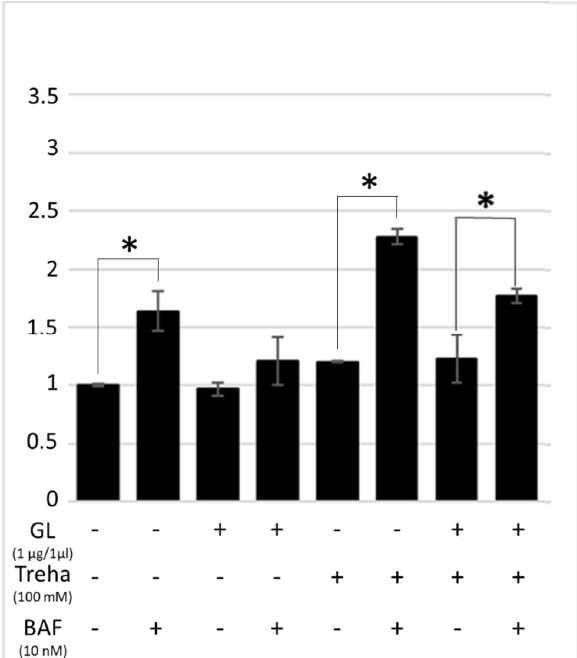
Figure 9. Cytofluorimetric analysis of LC3-II levels in Caco-2 cells treated with PT-gliadin (1 µg/µL) in presence/absence of trehalose (Treha) or raffinose (100 mM). Bafilomycin A1 (10 nM) was used to monitor differences the autophagic flux. The LC3-II expression values were normalized on the NT sample. The analysis was performed using a Muse ® Cell Analyzer (Merck). The asterisks indicate p < 0.05, ANOVA one-way, as compared with the relative control samples. SE bars are reported. The experiments were performed in triplicate. Cytofluorimetric plot are reported in Figure S7 (Supplementary Materials).